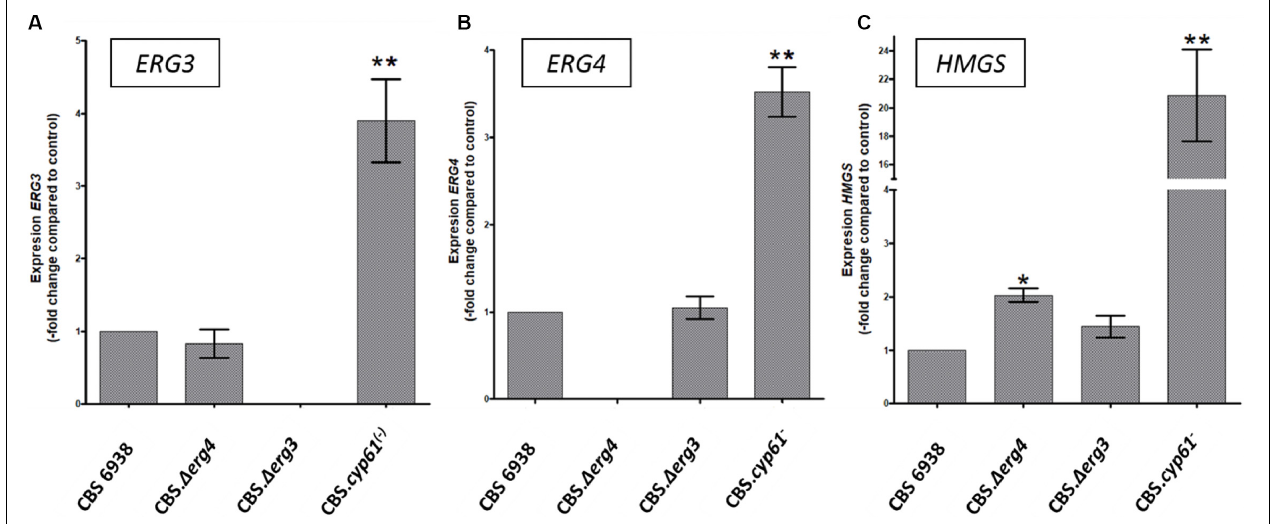
FIGURE 5 | Transcript levels of the HMGS , ERG3 and ERG4 genes from the X. dendrorhous strains studied in this work. Relative transcript levels of genes (A) ERG3 , (B) ERG4, and (C) HMGS were determined by RT-qPCR after 120 h of culture and normalized to the housekeeping gene encoding β -actin (GenBank: X89898.1). Values are the average ± standard deviation of three independent cultures (** p < 0.01, * p < 0.05; Student’s t